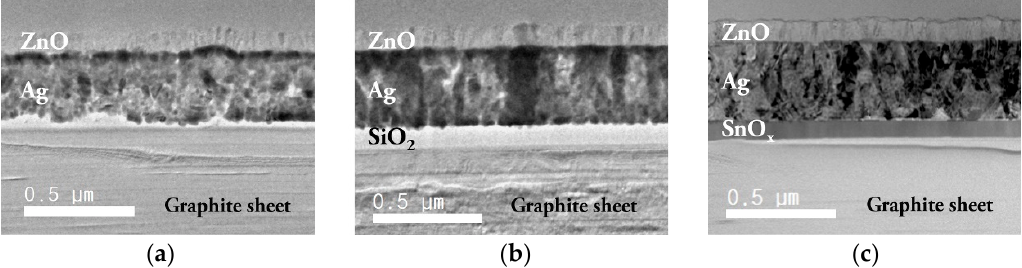
Figure 2. Cross-sectional transmission electron microscopy (TEM) images of the back reflector zinc oxide/silver (ZnO/Ag) on the graphite sheet deposited ( a ) without barrier layer, ( b ) with a 100 nm SiO 2 barrier and ( c ) with a 100 nm SnO x barrier.